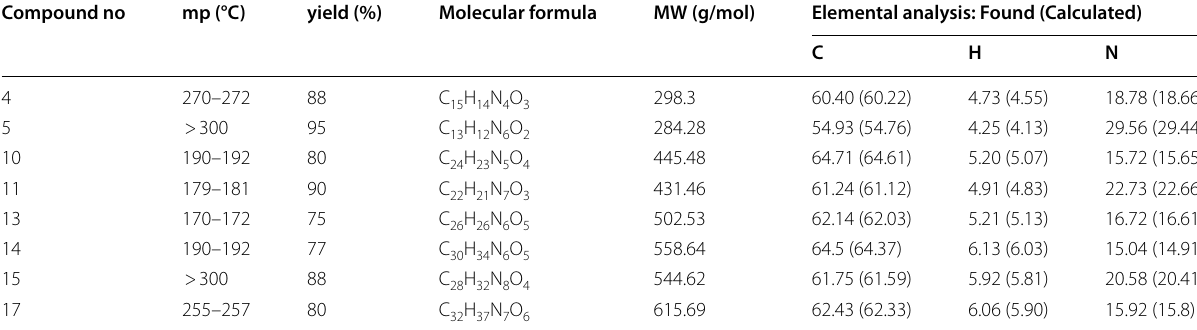
Mp: melting point, MW: molecular weight, C: Carbon, H: Hydrogen, N: Nitrogen